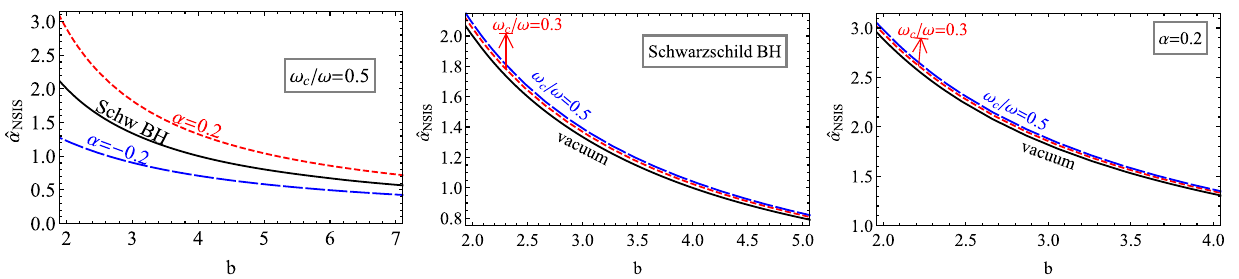
is devoted to the pure Schwarzschild case for the different values of the plasmafrequencywiththecomparisonofthevacuumcase,andtheright panel corresponds to the values of the MOG parameter α = 0 . 2. In all cases we take r c = 3 M